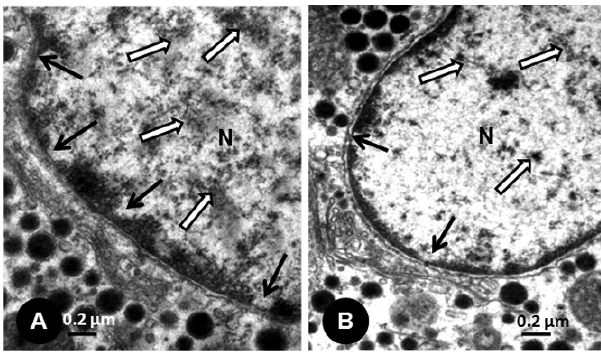
Figure 3 - Electronic photomicrographs of sections obtained from RA cardiomyocytes of mice from the sham (A) and OVX (B) groups showing the nucleus (N) with euchromatin (white arrows) and the pores of the nuclear membrane